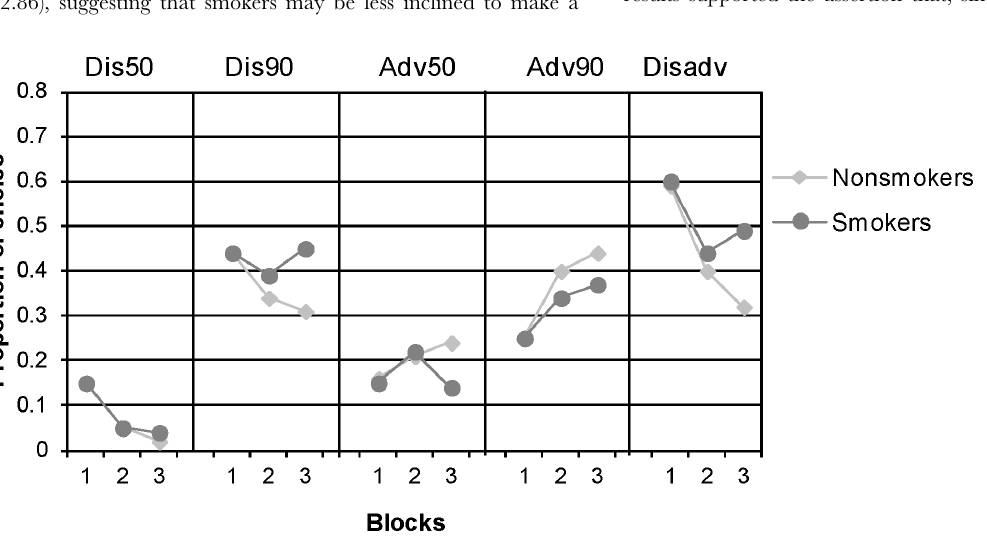
Figure 2. Smokers’ and nonsmokers’ choices as a function of time, by blocks of 20 trials, in the modified IGT (average proportions). The right column (Disadv) shows the proportion of choices from the disadvantageous decks (Dis50 +